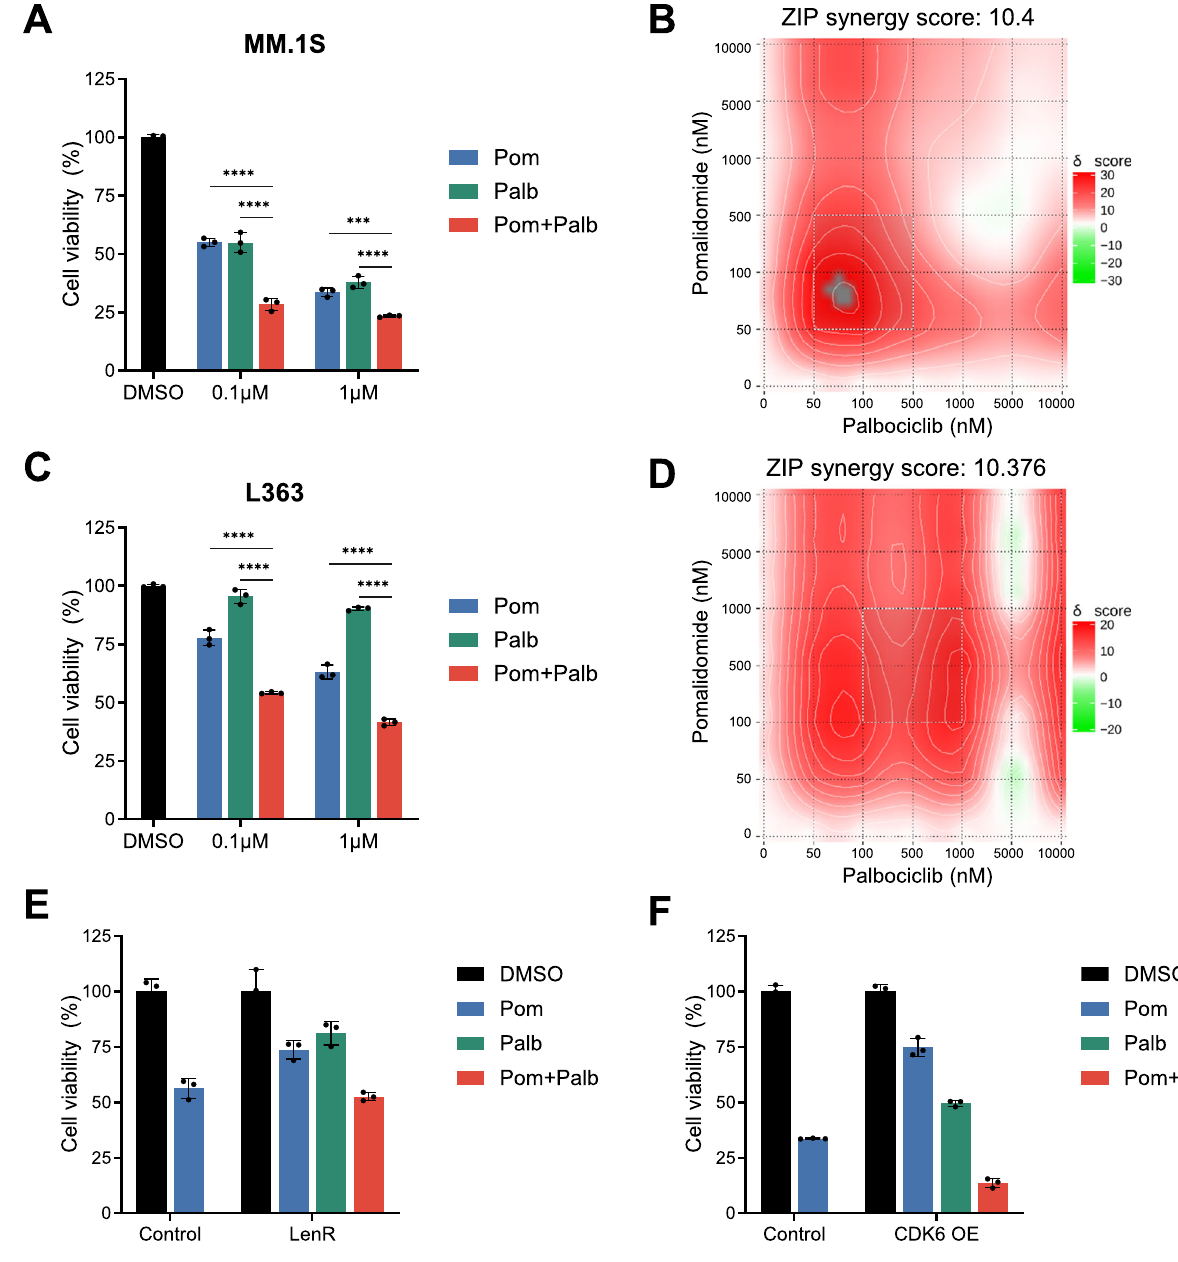
Fig. 3 CDK6 inhibition by palbociclib synergizes with IMiD treatment of multiple myeloma cells. A Cell viability of MM.1S cells treated 96 h with pomalidomide (pom), palbociclib (palb), or in combination. ( N = 3 biologically independent replicates). B Synergy map of MM.1S cells treated with palbociclib in combination with lenalidomide or pomalidomide. C Cell viability of L363 cells treated with pomalidomide, palbociclib, or in combination ( N = 3 biologically independent replicates). D Synergy map of L363 cells treated with palbociclib in combination with lenalidomide or pomalidomide. E Cell viability of MM.1S LenR cells ( N = 3 biologically independent replicates) and F OPM2 CDK6 OE cells upon combination treatment of pomalidomide and palbociclib ( N = 3 biologically independent replicates) Synergy levels are indicated with ZIP synergy scores. Synergy maps were generated with SynergyFinder 75 . Cell viability is normalized to respective DMSO conditions. Data represent the mean ± SD of biological triplicates. One-way ANOVA is applied. P values are displayed as follows: n.s. = P > 0.05; * P ≤ 0.05; ** P ≤ 0.01; *** P ≤ 0.001; **** P ≤ 0.0001. Source data are provided as a Source Data fi performed quantitative proteomic and phosphoproteomic ana- lyses in MM.1S cells treated with pomalidomide, palbociclib, and CDK6-speci fi c PROTACs alone or in combination (Fig. 6A, Supplementary Data 3). Global proteome analysis of drug-treated MM.1S cells identi fi ed 7460 proteins, of which 240 and 179 were signi fi cantly regulated by treatment with 24 h pomalidomide or palbociclib, respectively (0.1 FDR). In line with previous results, striking pattern where proteins upregulated in patient samples at